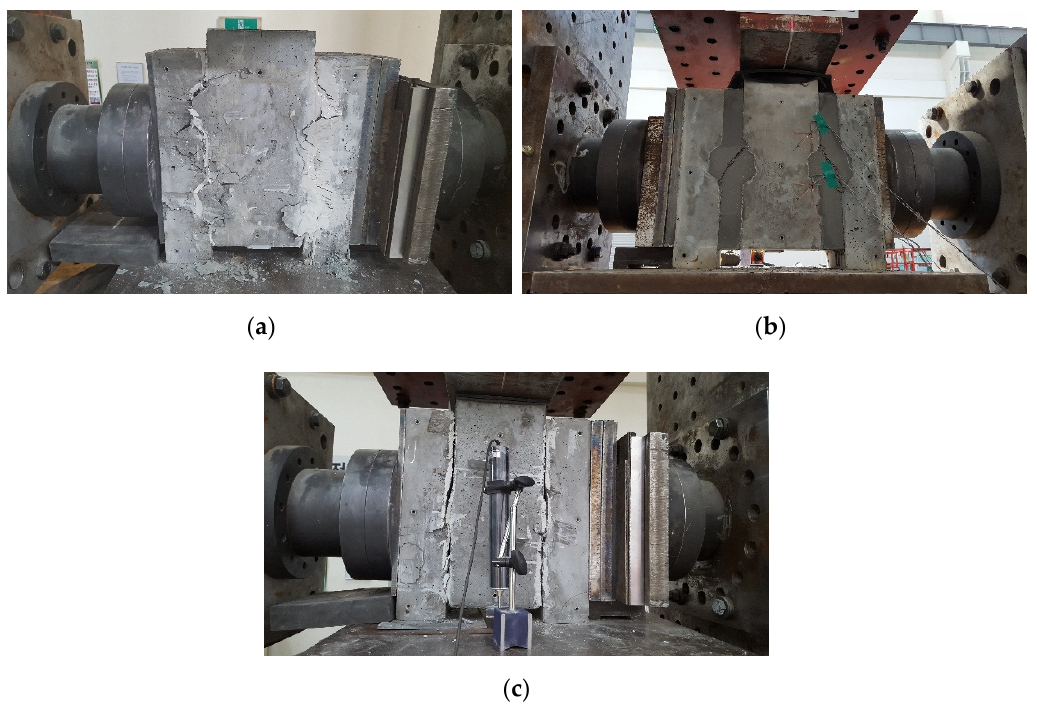
Figure 5. Failure shape of specimens: ( a ) multiple cracks (PC80-D-2-E-N-8-30-5); ( b ) diagonal cracks and shear-off (PC80-W-1-C-90-8-30-50); and ( c ) interface debonding (PC80-D-1-E-N-2-7.5-5).